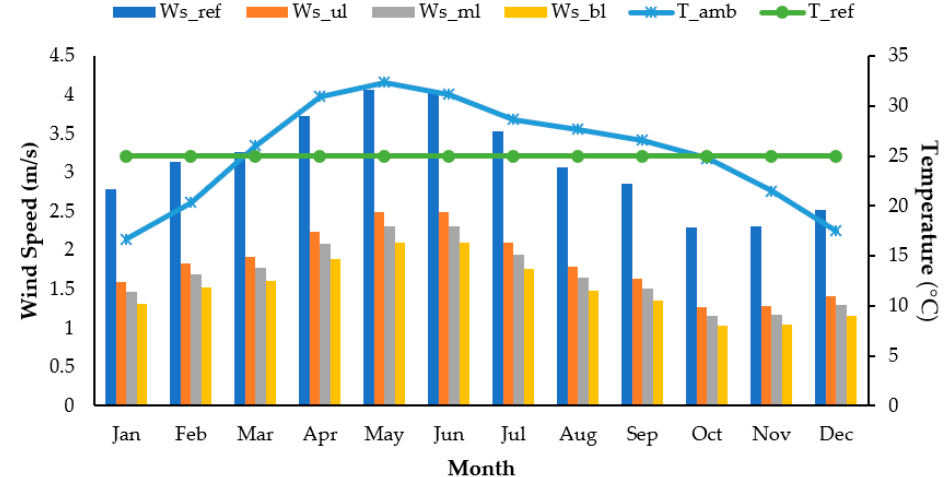
Figure 6. The observed wind speeds are the height variation of the three different layers of the proposed 3-L SPVT system and the ambient temperatures.